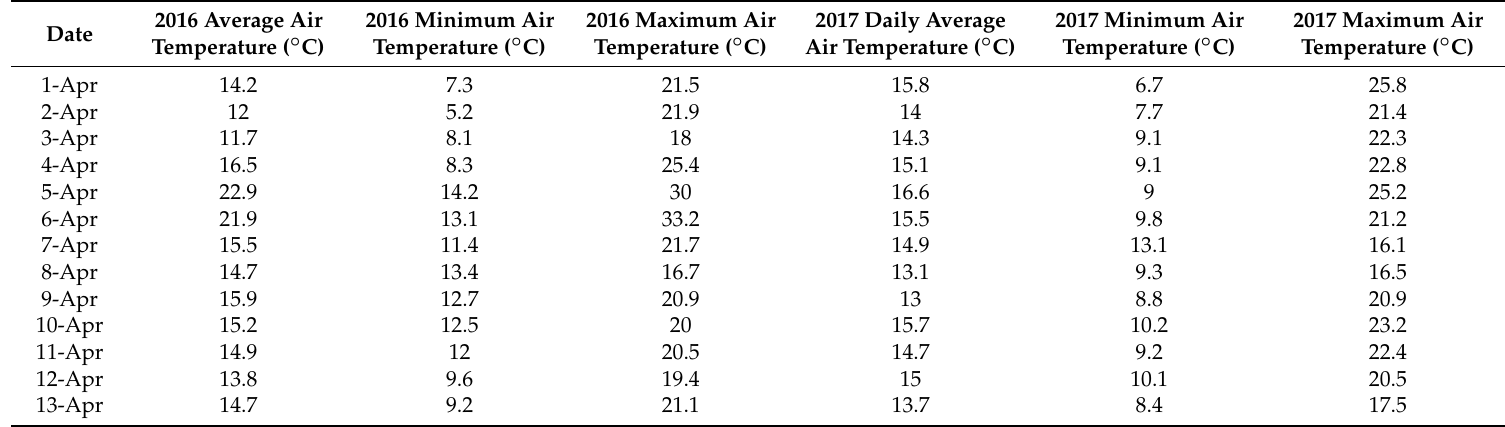
Table A7. Daily weather data from California Irrigation Information Management System (CIMIS) weather station 52 in San Luis Obispo during the 2016 and 2017 growing seasons. Daily average air temperature, minimum air temperature, and maximum air